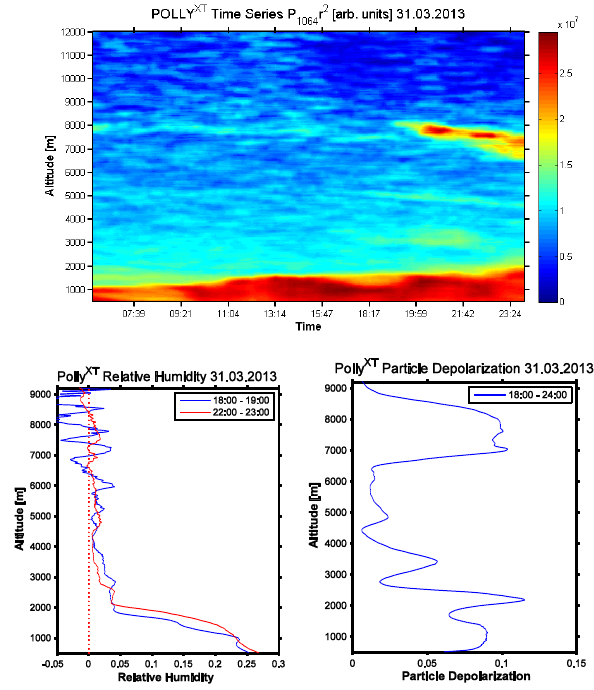
Figure 2. An example of the range-corrected signal at 1064 nm (top panel) of the Polly XT lidar 1317 in Vehmasmäki on 31 st March 2013. In the lower-left panel, one-hour average relative-1318 humidity profiles; and on the lower-right panel, four-hour average particle depolarization ratio 1319 profile is shown. 1320